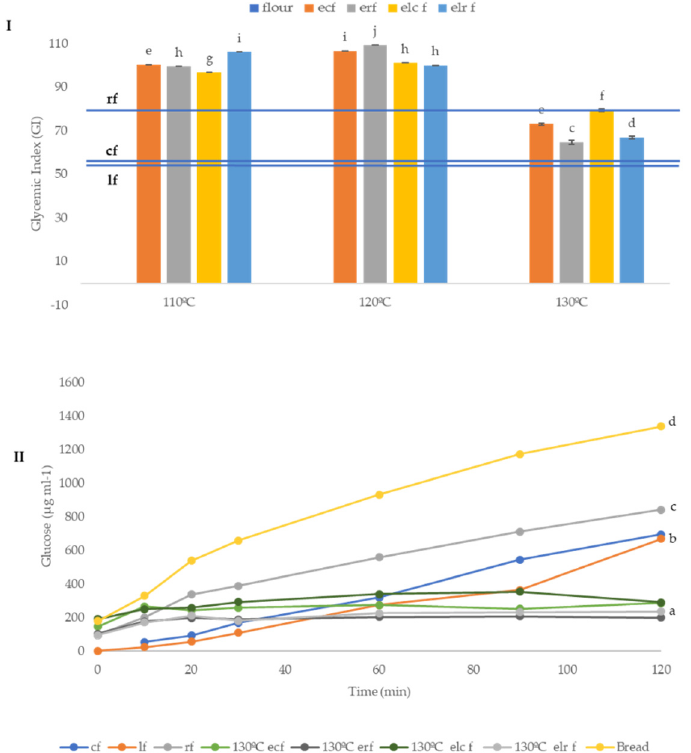
Figure 4. Glycemic index (GI, I ) and glucose kinetic consumption (µg mL − 1 ) ( II ) of native and extruded flours. Abbreviations: cf: corn flour; rf: rice flour; lf: lentil flour; ecf: extruded corn flour; erf: extruded rice flour; elcf: extruded lentil (50%)-corn flour; elrf: extruded lentil (50%)-rice flour. Different small letters indicate significant differences ( p ≤ 0.05) between